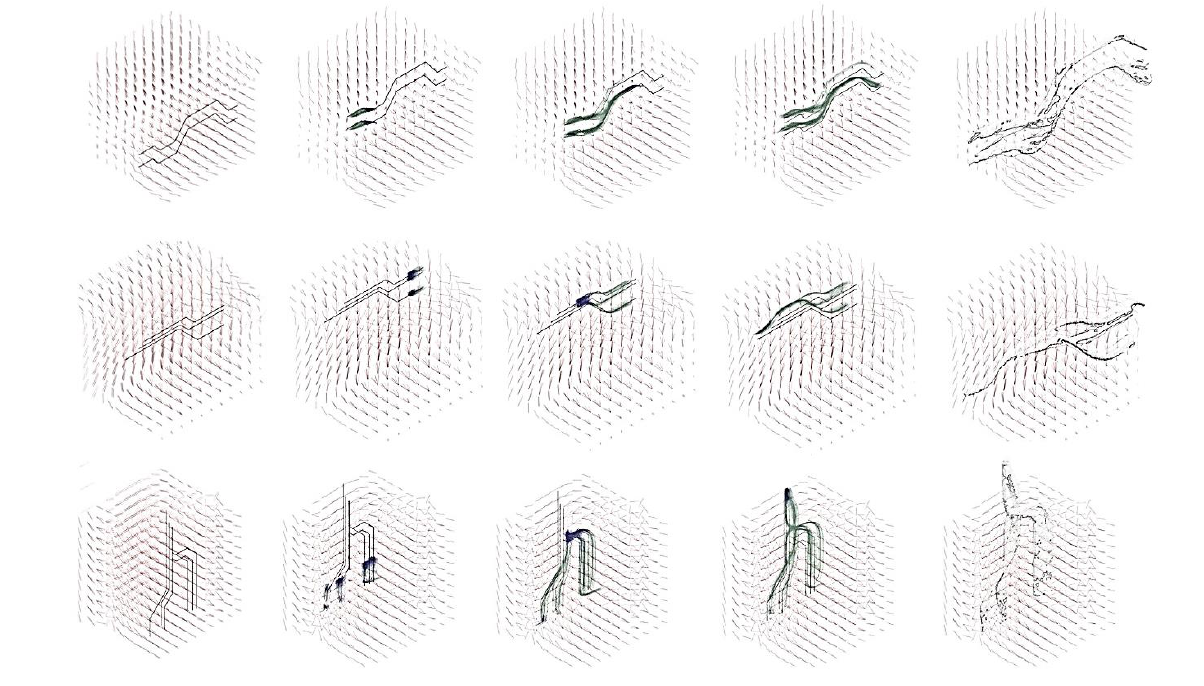
Figure 3. Proto-typing the architectural body - the interaction of the